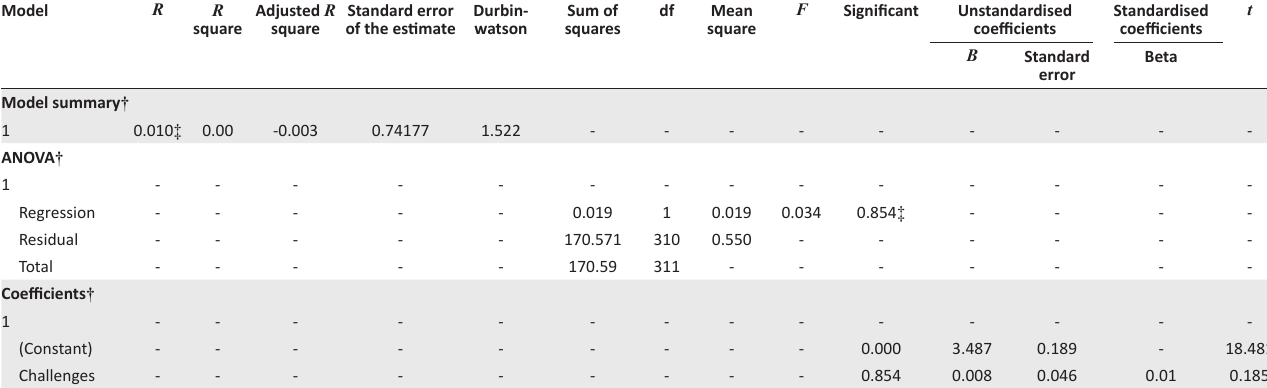
TABLE 4: Regression analysis: Challenges and digital human resource management practices.